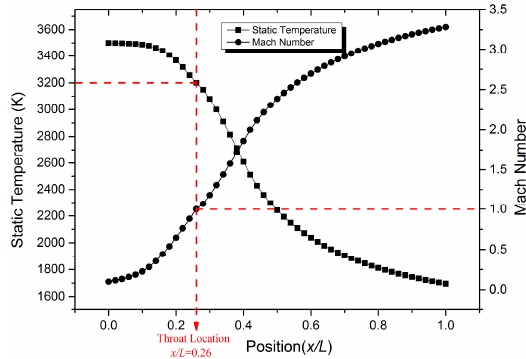
Figure 4. Curves of static temperature and Mach number along the nozzle axis.